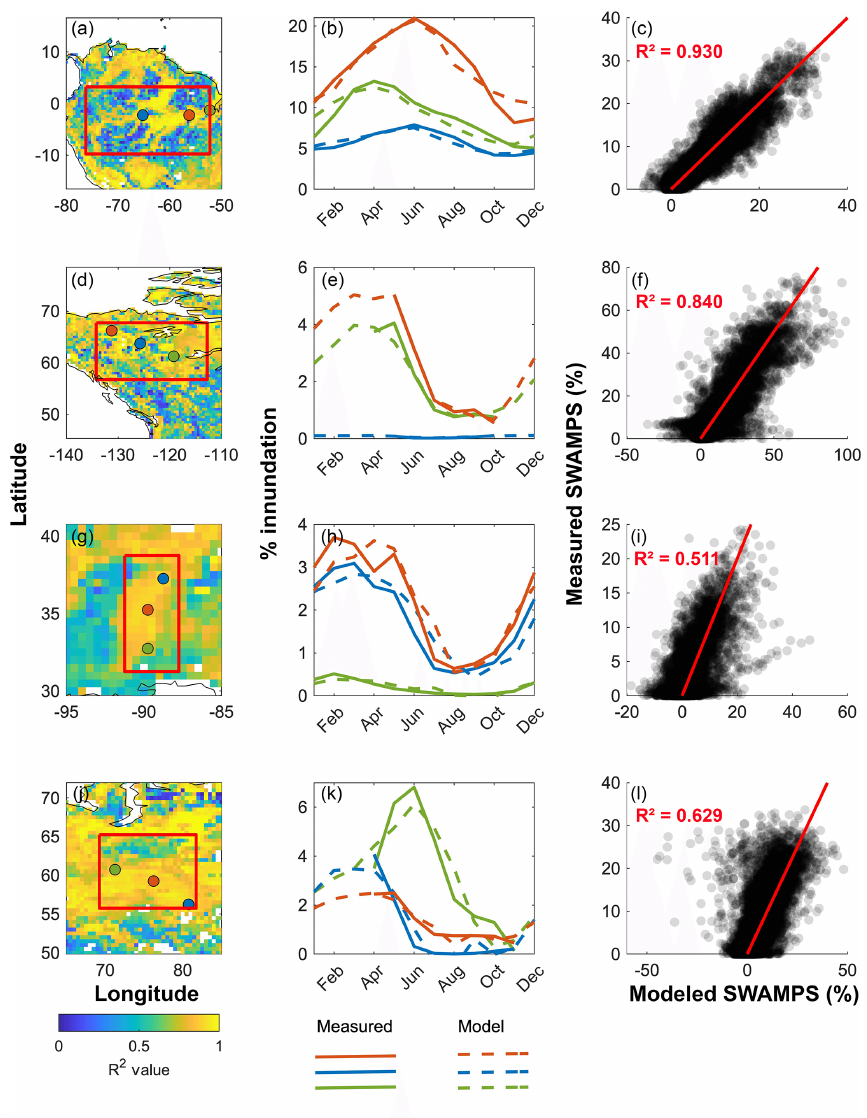
Figure 7. Cells included in scatter plots are outlined by the red boxes, and red, blue, and green dots denote the cell used for measured and modeled climatologies. Modeled inundation has a time lag correction of 0 to 5 months. (a) Amazon map. (b) Amazon measured and modeled climatologies. (c) Amazon scatterplot. (d) Mackenzie map. (e) Mackenzie measured and modeled climatologies. (f) Mackenzie scatterplot. (g) Mississippi map. (h) Mississippi measured and modeled climatologies. (i) Mississippi scatterplot. (j) Ob map. (k) Ob measured and modeled climatologies. (l) Ob scatterplot. Table 2. Coordinates for basin sites and the boundaries for cells included in the scatterplots. Amazon Mackenzie Mississippi Ob Site Longitude Latitude Longitude Latitude Longitude Latitude Longitude Latitude Green − 52 .